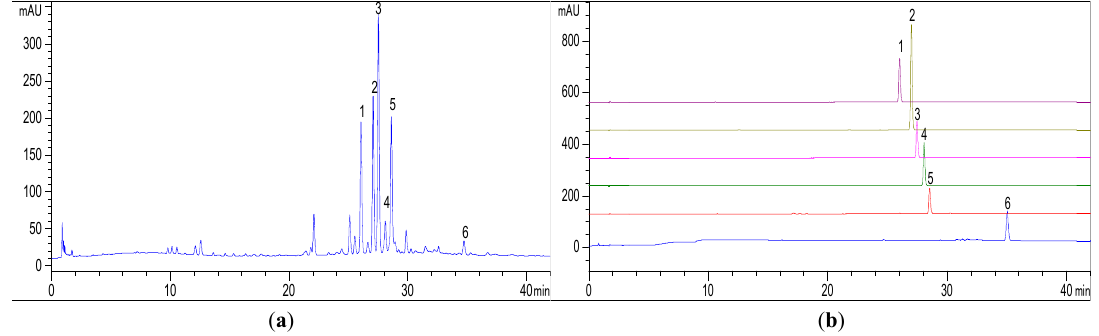
Figure 4. ( a ) HPLC analysis of the crude sample of E. yunnanensis . ( a ); ( b ) HPLC chromatograms spectra of MIAs ( 1 – 6 ). Conditions: YMC-Triart C 18 (150 × 9.6 mm, i.d., 5 μ ); flow rate, 1.0 mL/min; UV wavelength, 254 nm; solvent A (acetonitrile) and B (0.3% v / v aqueous acetic acid) in gradient elution